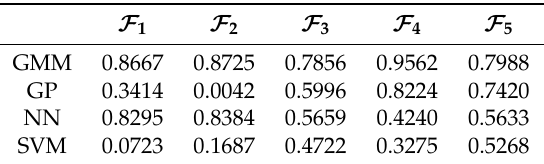
Table 3. Performance of classifiers ( MCC ) for the training dataset with different definitions of the feature vector F .